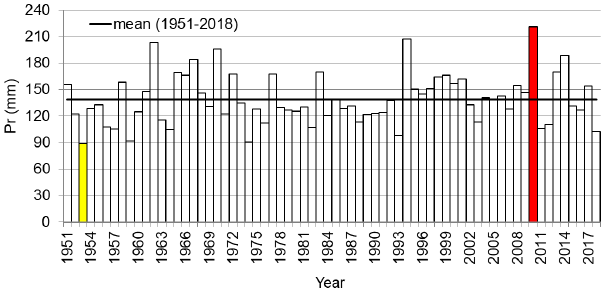
Figure 2. Variation of spring (March–May) area precipitation in Poland. Years 1951–2018. Table 1. Characteristics of spring (March–May) area precipitation in Poland. Years 1951–2018.